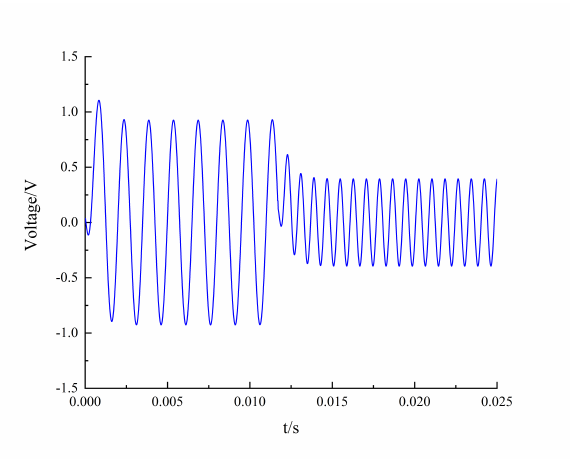
Fig. 12. Transient response of rail surface voltage under different transmission